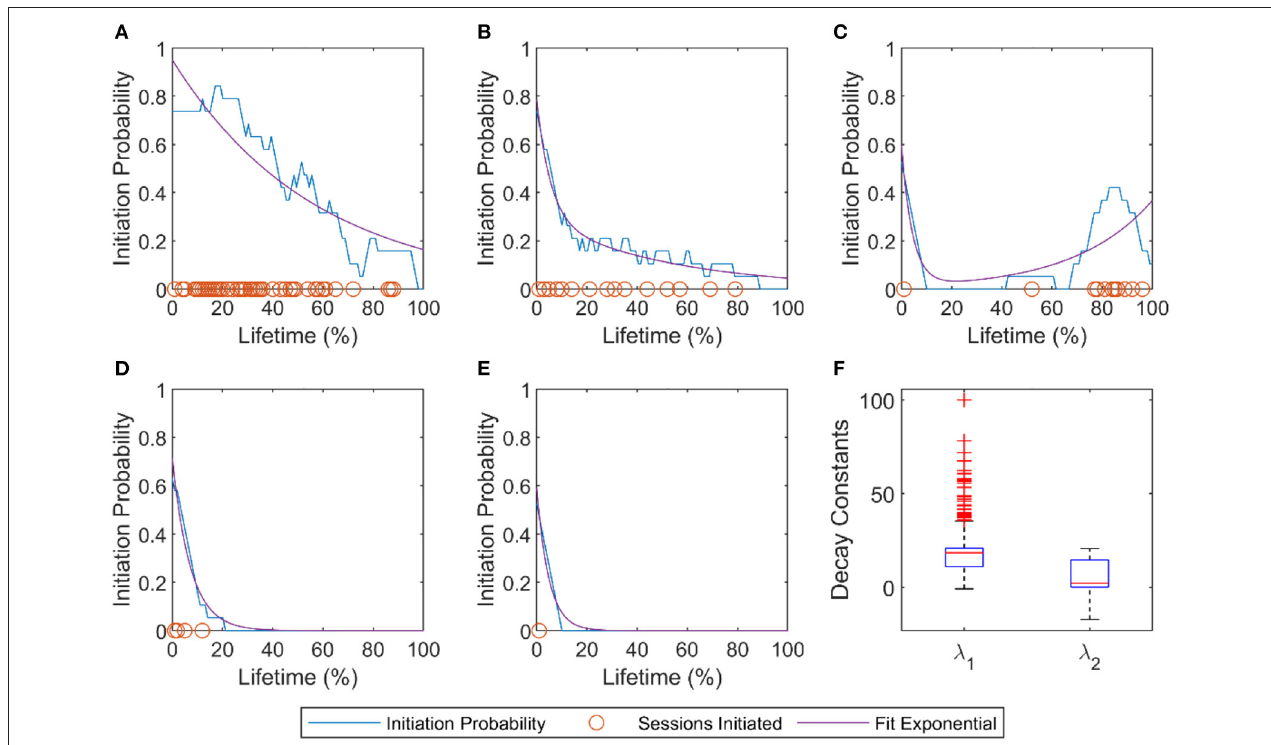
FIGURE 10 | Pattern of individual users’ session initiation probabilities. (A–E) Examples of five users’ session initiation probability demonstrating a variety of the usage patterns. Orange circles mark initiation of at least one exercise session at that lifetime %. The blue line is the probability of initiating at least one session calculated with a sliding window average (window size 19). The purple line is the sum of two exponential functions fit to each user’s probability of session initiation curve. (F) Decay = ae − λ 1 x be − λ 2 x , the average coefficients of the population were a constants of the two exponentials. For the model fit, f ( x ) = + b 0.43 0.17, λ 2 6 8.7 = ± = ±